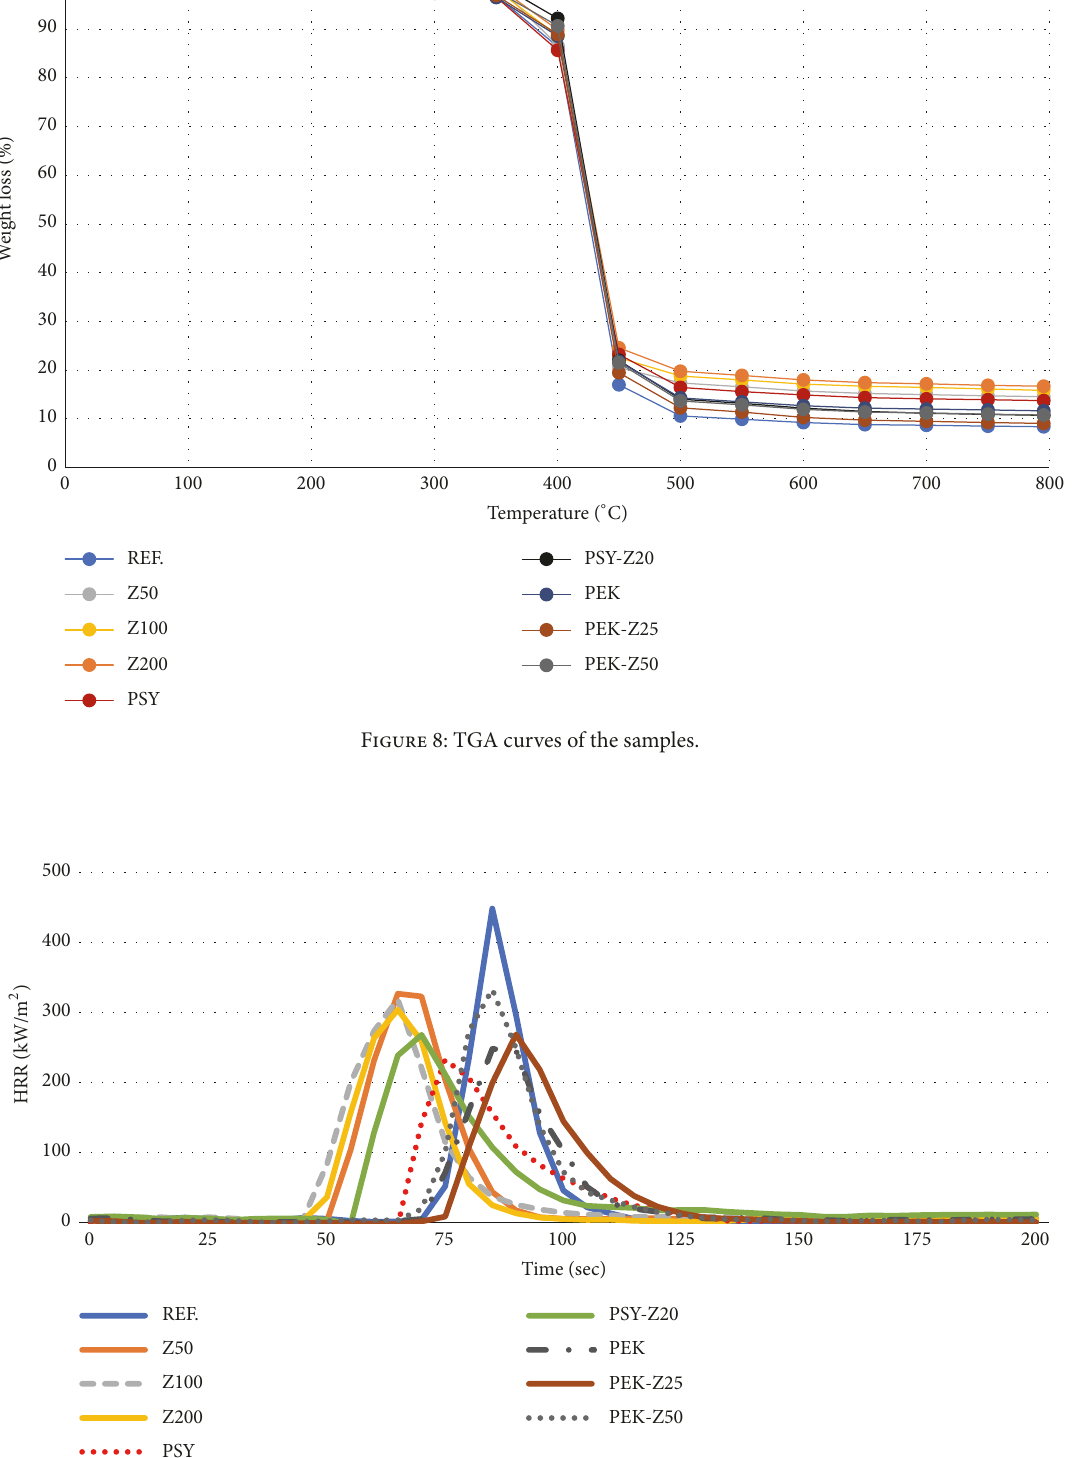
Figure 9: HRR curves of all